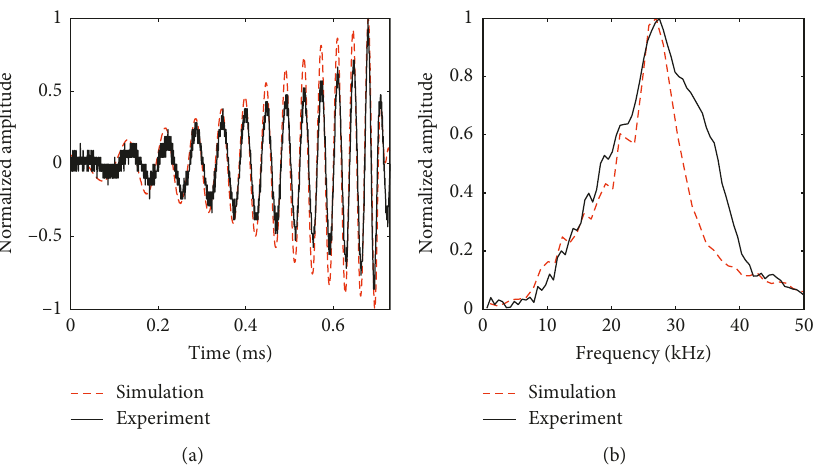
Figure 6: Time-domain waveform and spectra of the difference frequency signal. The simulation results were calculated based on the KZK equation.